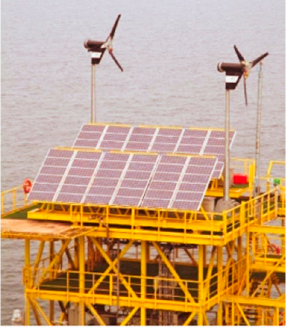
Figure 8. Wind turbines and solar panels on offshore platform [37]. Reprinted with permission from Ref. [Fossil-Fuel Platform Runs on Renewable Energy]. 2006, Rosebro, J.